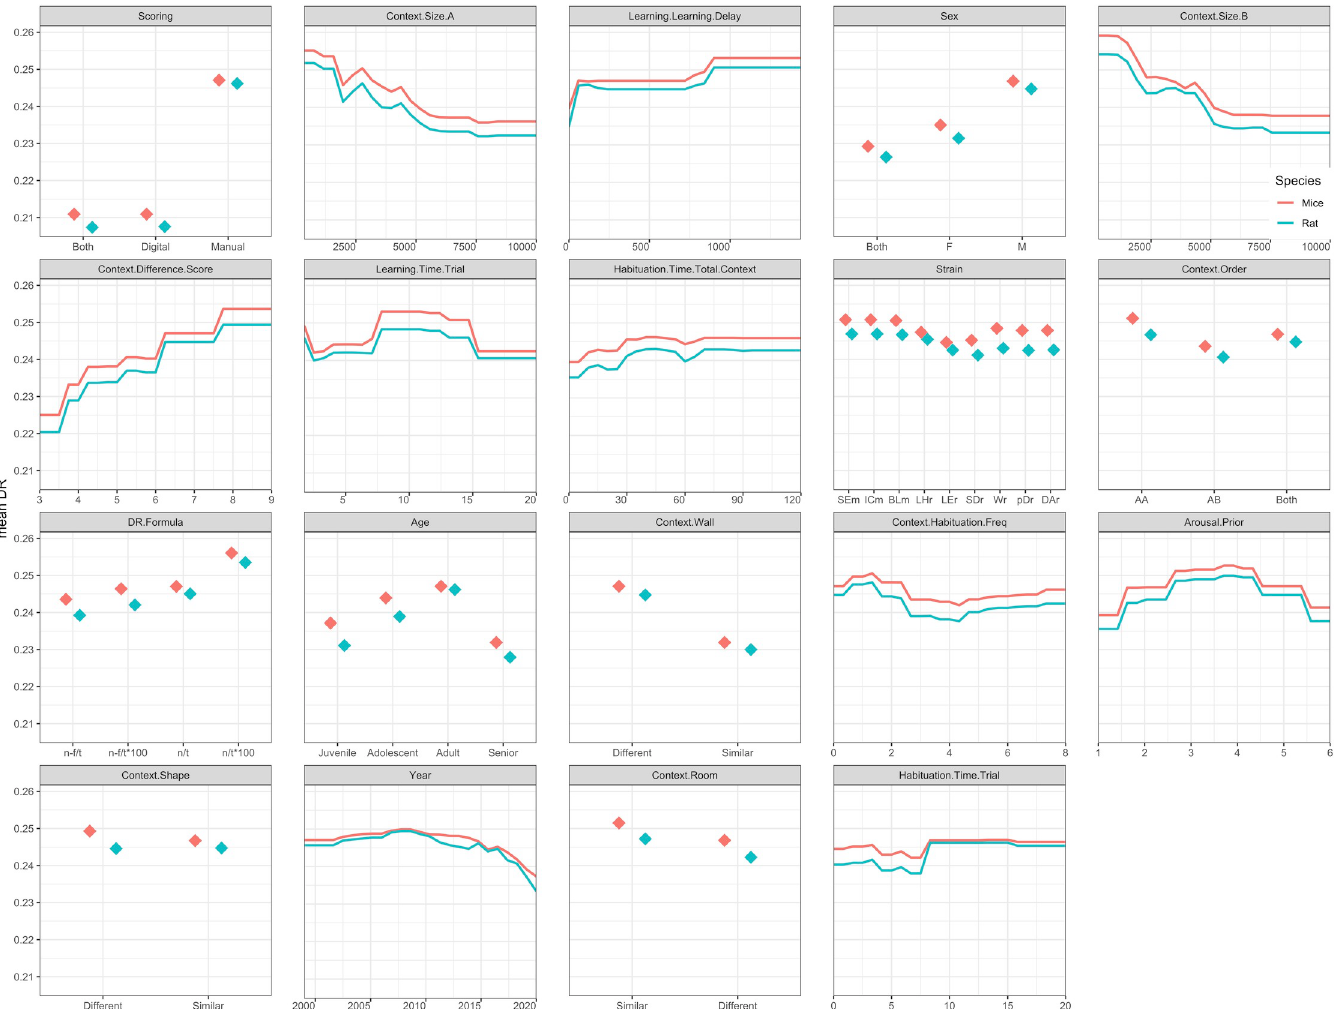
Fig 7. Partial dependence plots showing the predicted relation between DR and the upper half most important variables in the random forest-based meta-analysis, broken down by species: Mice in red vs. rat in blue. The y-axis shows the predicted DR and x-axis shows the values of the variable that is named above the graph (in gray). The values of context.size A and B are shown in in cm 2 and the values of time variables (learning. learning.delay, learning.time.trial, habituation.time.total.context, habituation.time.trial) are shown in minutes. Higher context.difference.score values indicate more different contexts and higher arousal.prior values indicate more arousal prior to the experiment. Strains values are abbreviations: TMm (Tg(Sim1cre)KH21Gsat/Mmucd mice), SEm (SEm Sv/Ev mice), ICm (ICR mice), BLm (C57BL/6 mice), LHr (Lister hooded rats), LEr (Long-Evans rats), SDr (Sprague-Dawley rats), Wr (Wistar rats), pDr (pigmented DA strain rats), DAr (Dark Agouti rats).